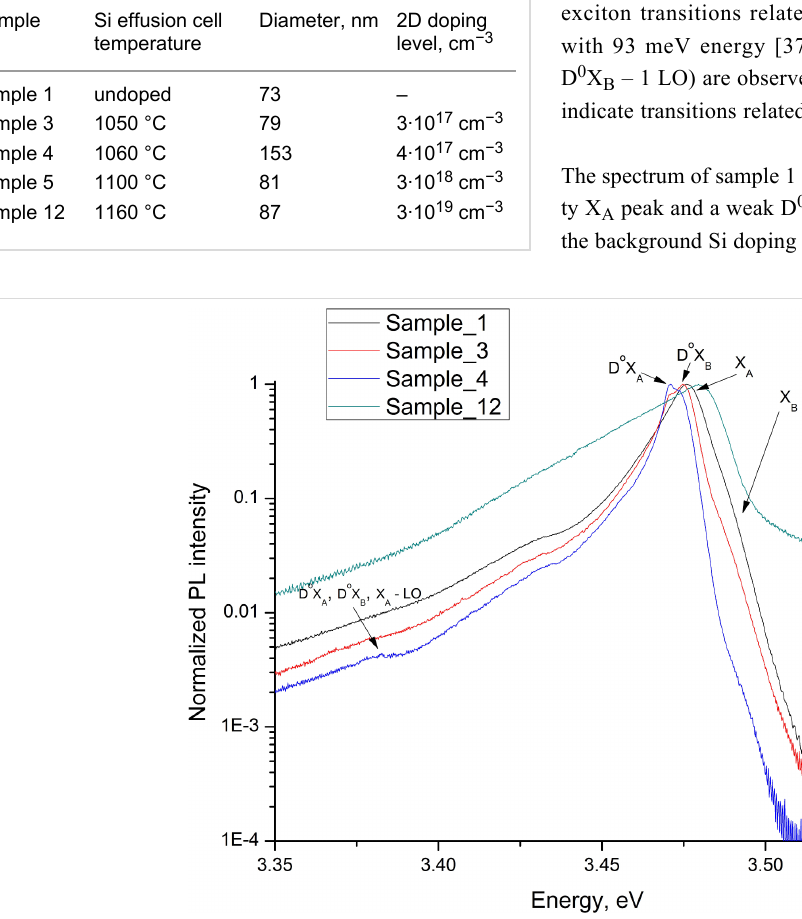
Table 1: Parameters of the samples analyzed with photolumines- cence. The 2D doping level is the doping level for planar GaAs grown with a corresponding growth rate and Si doping